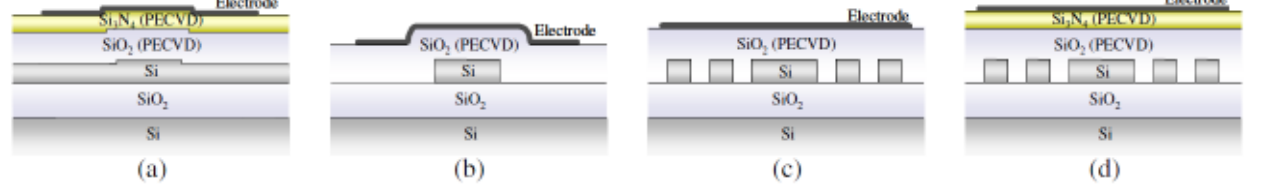
Figure 12. Different waveguide geometries investigated as part of a Mach–Zehnder interferometer. ( a ) shallow etched ridge waveguide; ( b ) fully etched strip waveguide; ( c ) photonic crystal waveguide with PECVD oxide cladding; ( d ) photonic crystal waveguide with combined oxide and nitride cladding. Figure is taken from Reference [47] with courtesy of